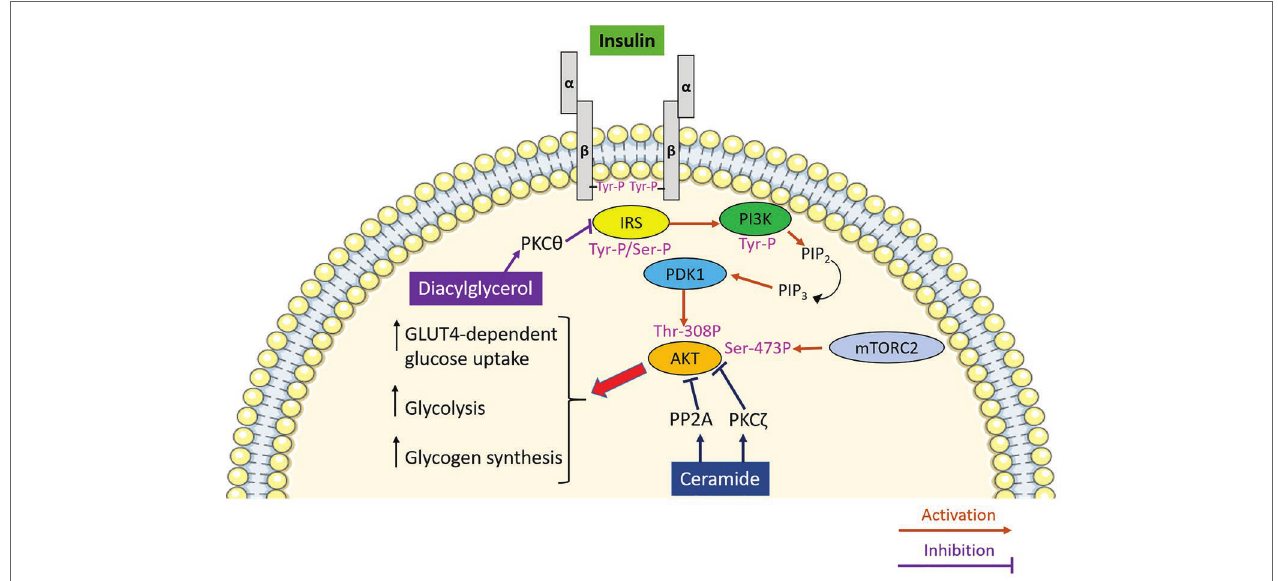
FIGURE 1 | The role of lipotoxicity in promoting insulin resistance in skeletal muscle. Insulin upon binding to its receptor activates a signal transduction pathway culminating in the PDK1 and mTORC2-mediated phosphorylation and activation of AKT, which, by modulating its downstream effectors, promotes glucose uptake, glycolysis and glycogen synthesis in skeletal muscle. Diacylglycerol inhibits insulin signalling by activating protein kinase C θ (PKC θ ) which phosphorylates insulin receptor substrate (IRS) on serine residues, thereby inhibiting it. Ceramide impedes insulin signalling via two separate mechanisms involving PKC ζ -induced phosphorylation and protein phosphatase 2A (PP2A)-mediated dephosphorylating of